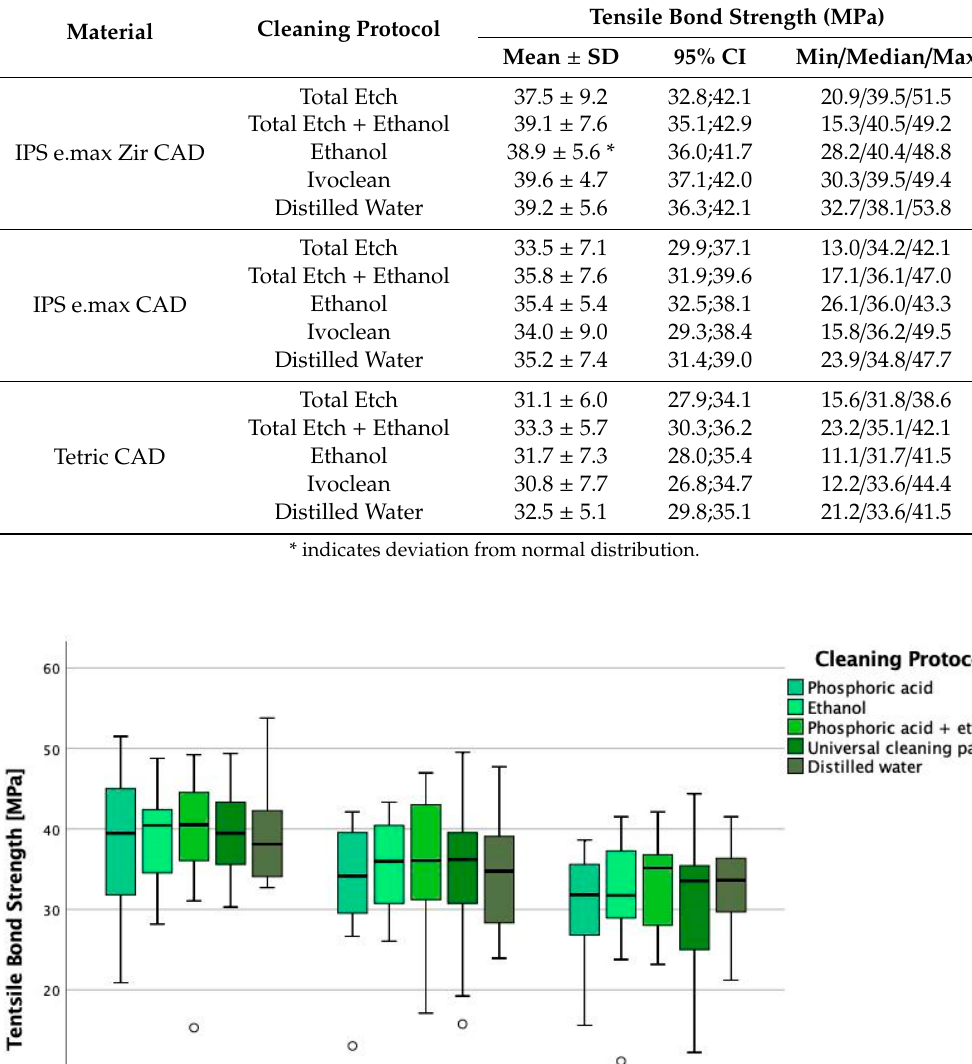
Table 3. Descriptive statistics of tensile bond strength in MPa with mean ± standard deviation (SD), 95% confidence interval (CI), minimum, median, maximum according to the CAD/CAM materials and the applied cleaning protocol.